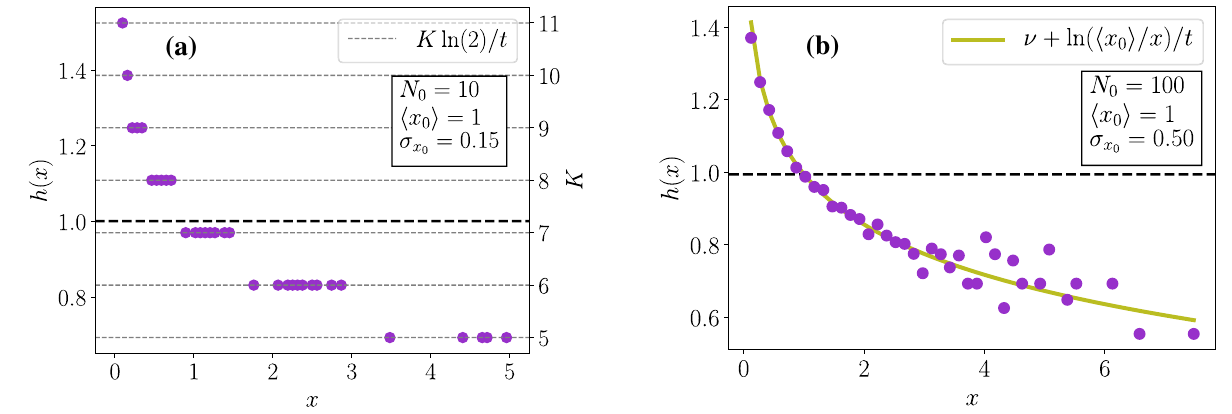
Figure 4. Size fitness landscapes for size models with B ( x ) = ν x α , constant ν = 1 , α = 1 , t = 5 , symmetrical division and N 0 initial cells following a Gaussian distribution of sizes N ( (cid:31) x 0 (cid:30) , σ x 0 ) . The black horizontal dashed lines represent the population growth rates (cid:31) . In ( a ), there is small variability in initial sizes: N 0 = 10 , / � x 0 � = 0.15 . The grey dotted lines represent the plateaus available for h ( x ), depending on the number σ x 0 of divisions K . The right y-axis displays the values of K corresponding to these plateaus. In ( b ), there is large variability in initial sizes: N 0 = 100 , σ x 0 / � x 0 � = 0.5 . The green curve is the theoretical prediction, on which the simulated purple dots